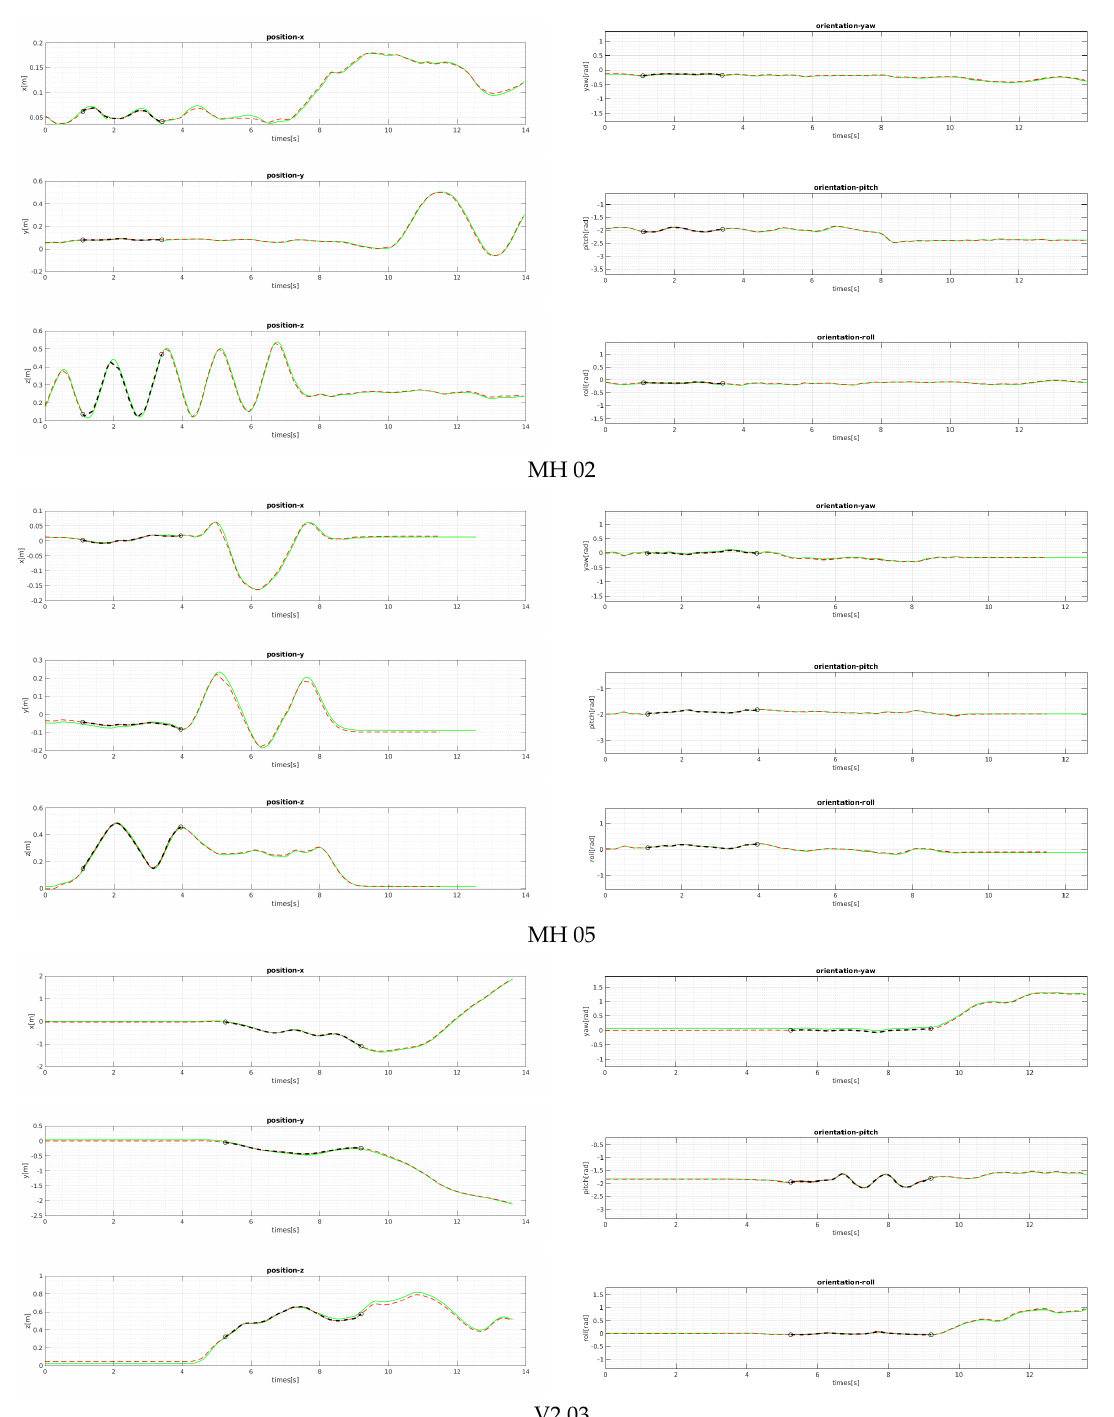
Figure 12. The comparison of the ground-truth positions and orientations with ours. The ground-truth values are plotted in green, and the estimated values are the red dashed lines. The black lines represent the section where the bootstrapping takes place. Note that it starts when there exists enough motion and finishes when the two confidence metrics are satisfied (Figure 11). The graphs show that the our adaptive proposed initialization method estimates the scale and bias parameters reliably and